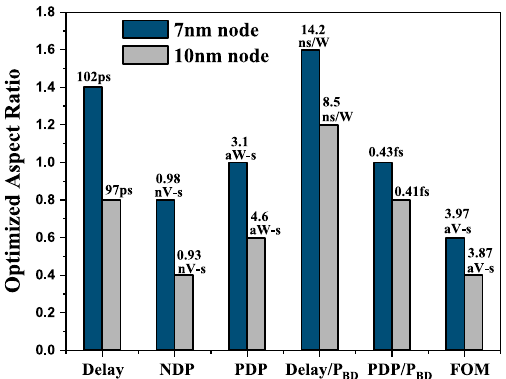
Figure 12. Impact of scaling on Fecl 3 doped MLGNR interconnect of length 10 µ m (Intermediate level).